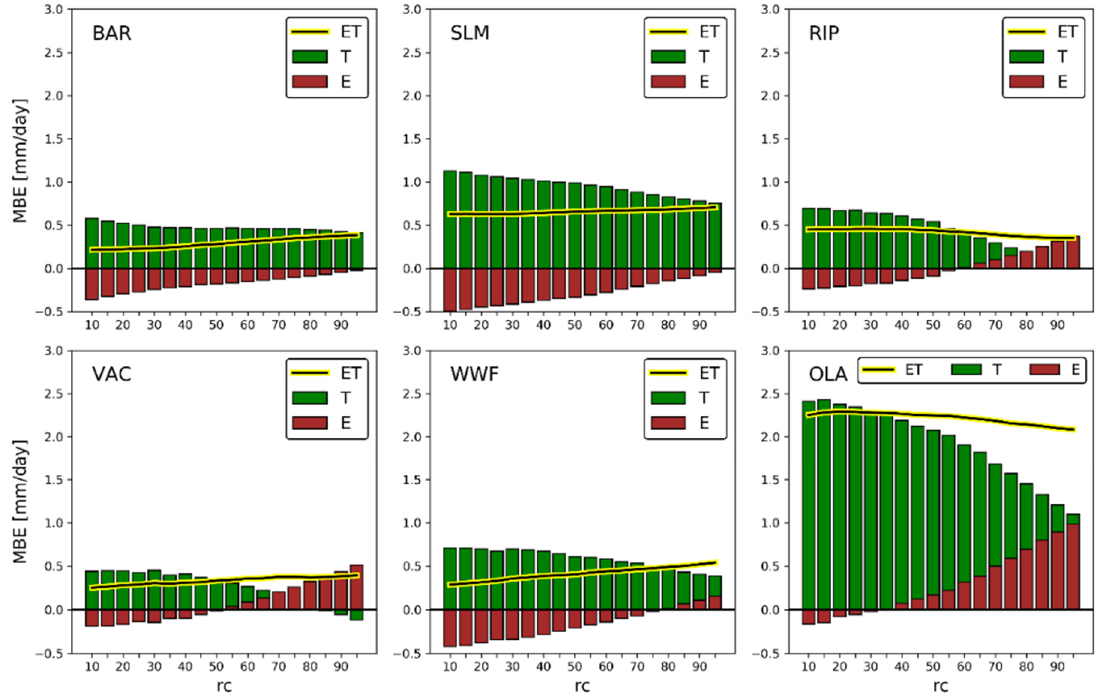
Figure 8. Bar plot of mean bias error (MBE; mm day − 1 ) between the DisALEXI-PM-derived T or E and the CEC-derived T or E, green bar and brown bar, respectively, for each site. MBE is calculated for individual DisALEXI-PM model run when r c is varied at 5 s m − 1 increments from 10 to 95 s m − 1 .